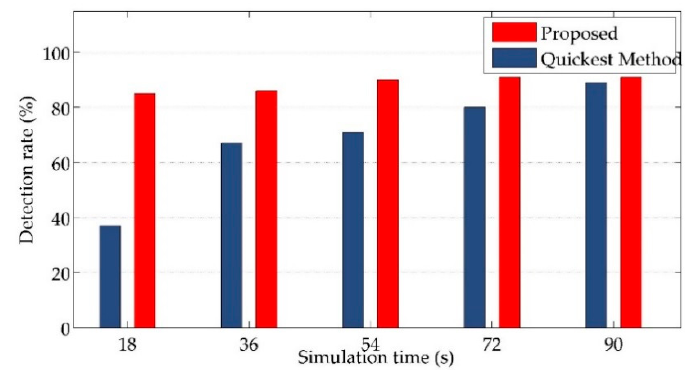
Figure 11. Analysis on the successful detection rate.